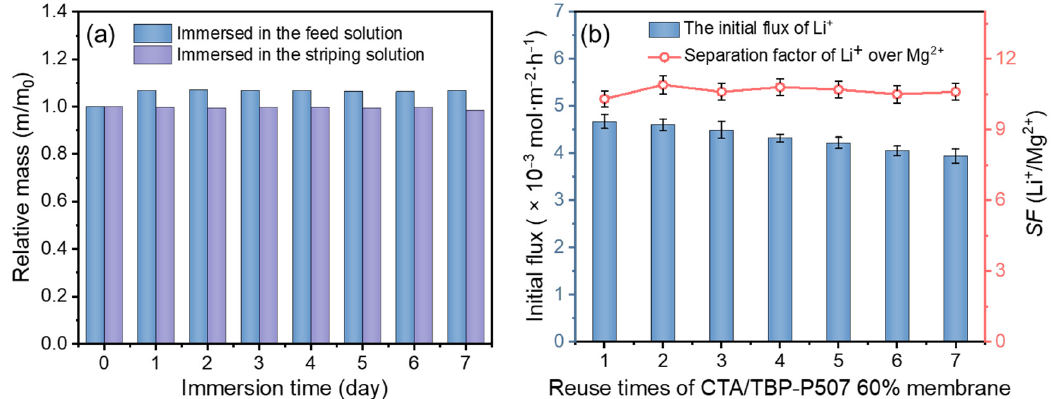
Figure 9. ( a ) Mass change of PIM after immersion in the feed solution and the striping solution (m 0 : the initial mass, 119.5 ± 0.3 mg; weighing interval: every 24 h); ( b ) reusability performance of the PIM system (feed solution: 0.1 mol/L LiCl, 4.0 mol/L MgCl 2 and 0.13 mol/L FeCl 3 ; test time: 24 h for one cycle; n = 5).